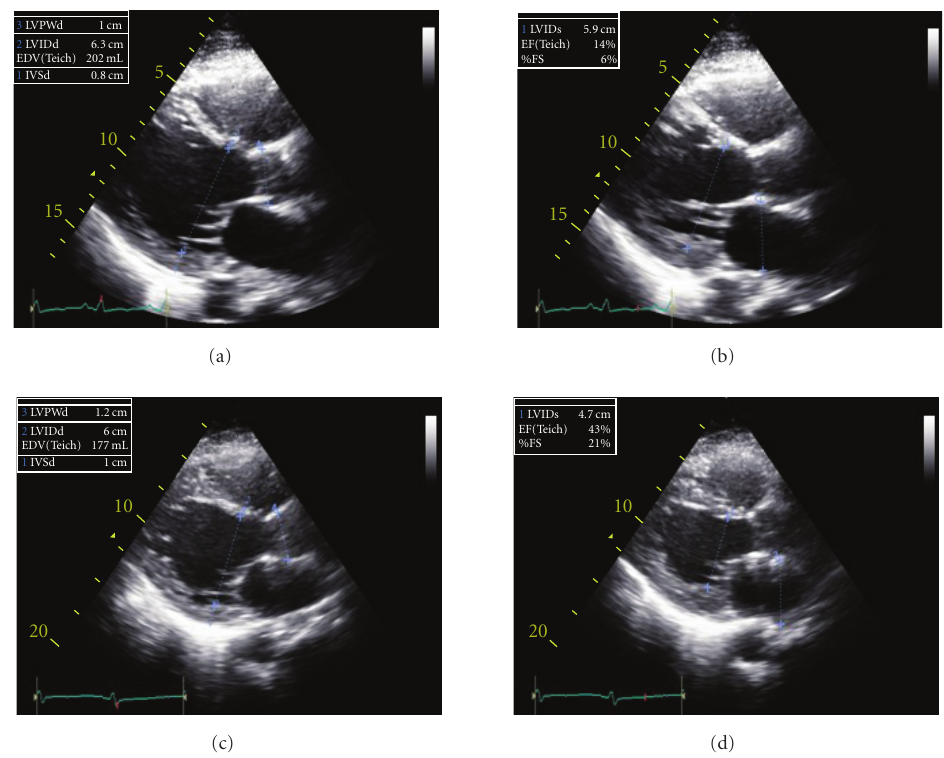
Figure 4: Parasternal long-axis views showing severe baseline LV dysfunction (Figures 4(a) and 4(b)) and improved ejection fraction on the followup study (Figures 4(c) and 4(d)).